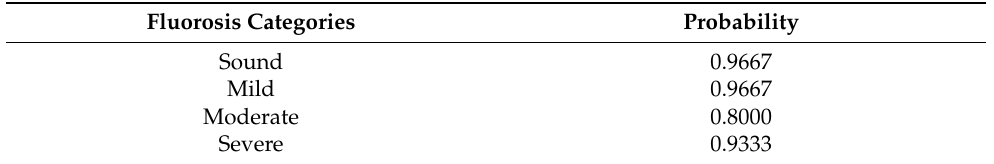
Table 1. Linear discriminant analysis (LDA). Probability of being correctly classified by the LDA model for the dental fluorosis categories.